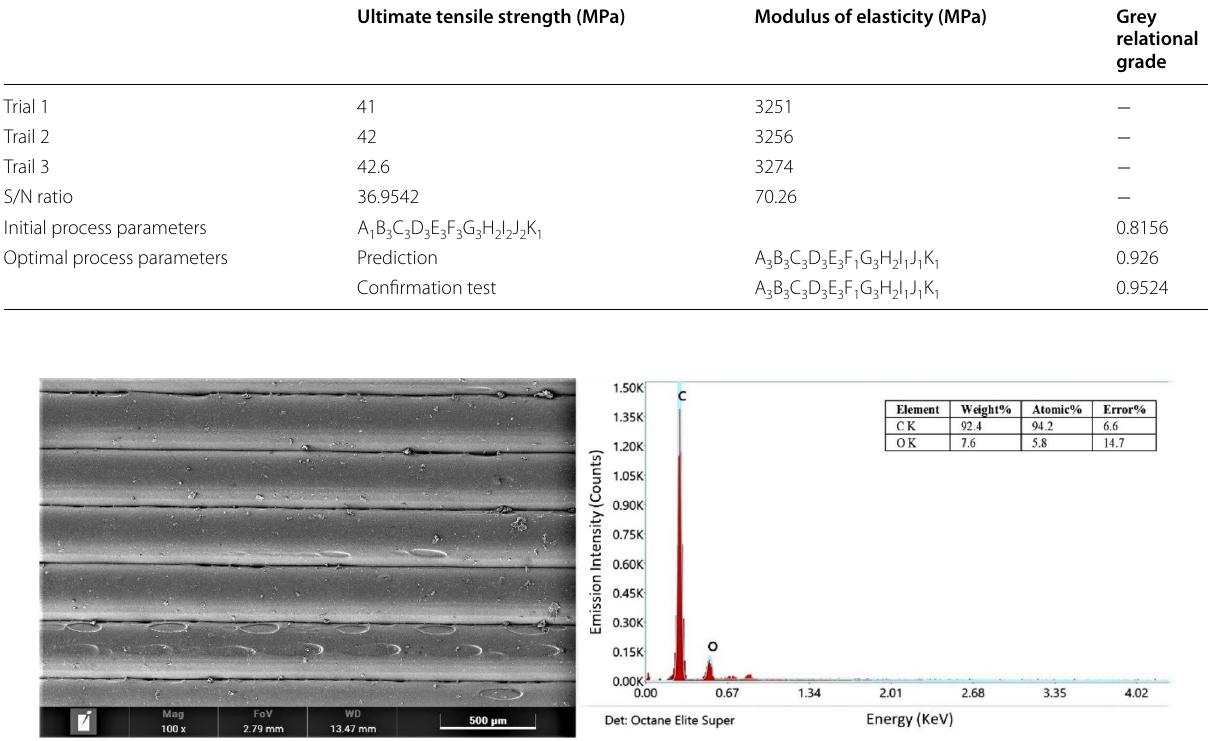
(Table 4), exactly stands for the optimum combination of factor levels for the FDM process in this work. The anal- ysis of variance is applied to the grey relational grades (Table 5) to ascertain the significant factors. Table 5